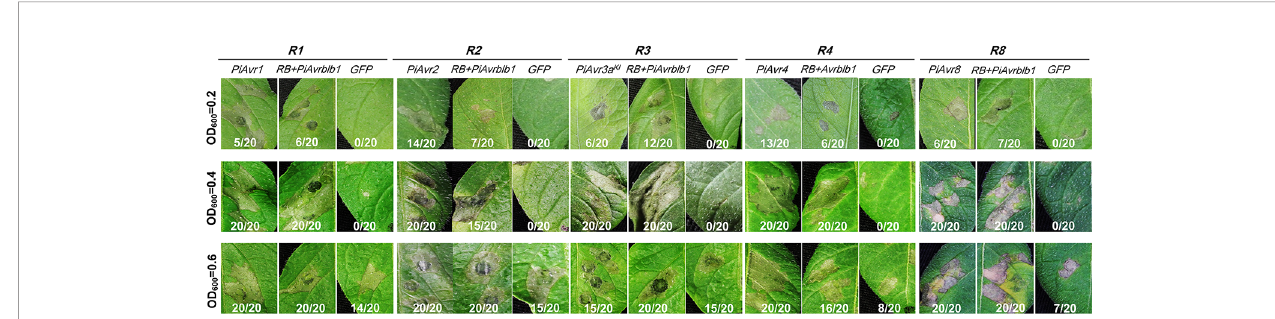
FIGURE 2 | Effects of OD 600 values of agrobacterial suspension on the HR response mediated by recognition of P. infestans Avr genes. Different OD 600 values, 0.2, 0.4 and 0.6, were examined for genotype-speci fi c HR triggered by P. infestans Avr genes on potato differential lines carrying the cognate R genes. A. tumefaciens AGL1 suspensions carrying P. infestans Avr genes PiAvr1 , PiAvr2 , PiAvr3a KI , PiAvr4 , and PiAvr8 , were in fi ltrated in potato differential genotypes carrying R1 , R2 , R3a , R4 and R8 , respectively. Co-in fi ltration of agrobacteria carrying PiAvrblb1 and RB was used as a positive control, while GFP as a negative control. The number of HR sites/total number of in fi ltration sites were indicated. The experiment was repeated three times with 20 replicates. All images were taken at 5 – 7 dpi.